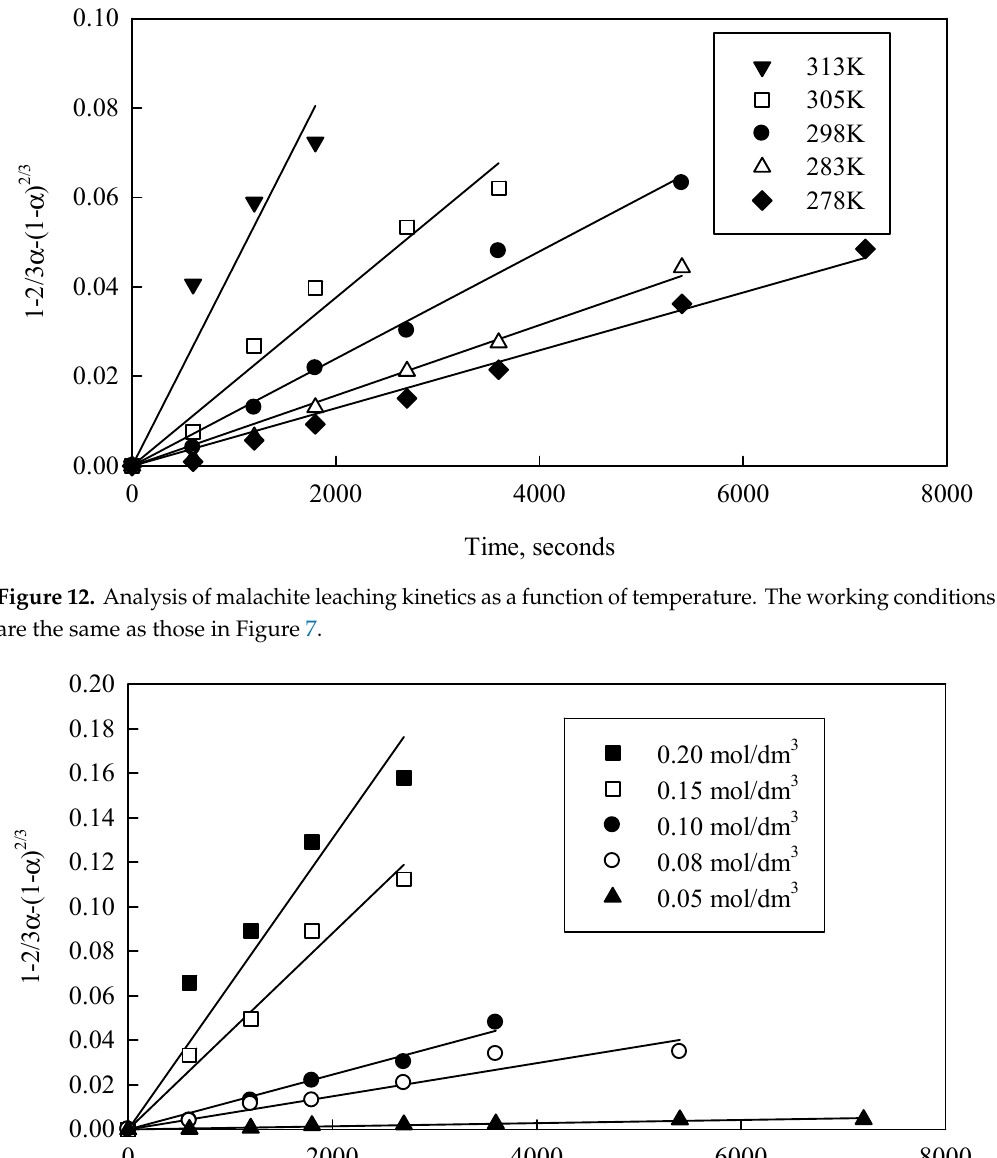
Figure 14. Reaction order calculated with regard to the concentration of NH 4 OH. For a kinetic model that is controlled by diffusion through a porous layer, the apparent constant values should vary linearly with the inverse square of the initial particle radius, as seen in Equation (12). In order to verify this, the particle size data (Figure 9) were entered into Equation (12), generating the graph shown in Figure 15.